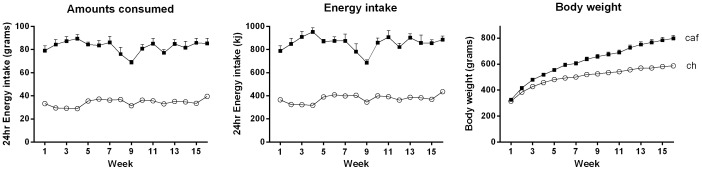
Cafeteria-fed rats consumed more food and energy, and weighed more than chow-fed rats.Mean (±SEM) weekly 24 hr food intake in grams (left), energy intake in kilojoules (middle), and weekly body weight (right), in rats fed either standard lab chow (open circles) or a cafeteria (closed squares) diet for 16 weeks. Data were analyzed using repeated measures ANOVA (energy intake, n = 6 cages per group; body weight, n = 12).